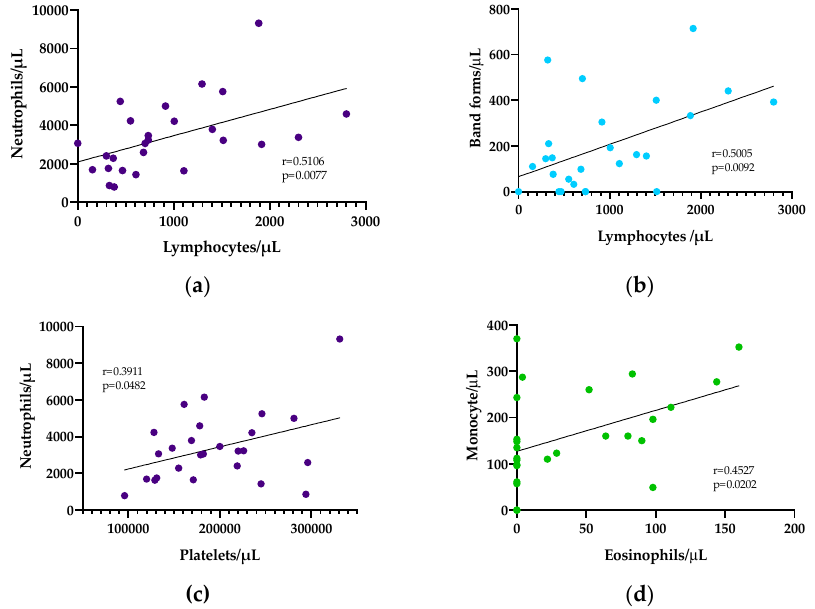
Figure 5. Correlation analysis of lymphocytes and neutrophils with other blood cell indices. ( a ) Lymphocytes vs. neutrophils, ( b ) Lymphocytes vs. band forms, ( c ) Neutrophils vs. platelets, and ( d ) Monocytes vs. eosinophils.